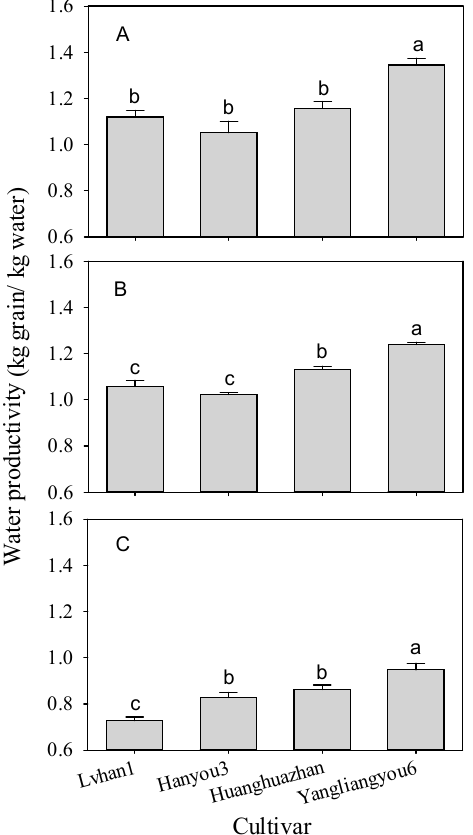
Figure 4. Comparison of water productivity (WP) among tested rice cultivars in 2012 ( A ), 2013 ( B ), and 2014 ( C ). Lvhan1 (inbred) and Hanyou3 (hybrid) are typical upland rice cultivars. Huanghuazhan (inbred) and Yangliangyou6 (hybrid) are well-known lowland rice cultivars Error bars represent SE. Different letters in each year means the significant differences at 0.05 level.